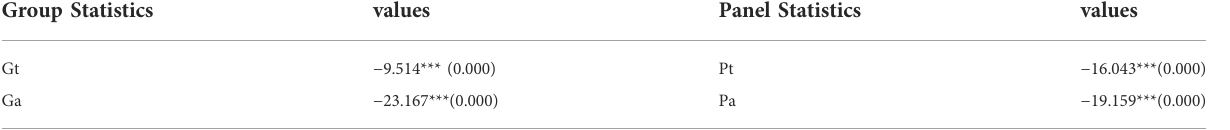
TABLE 5 The (Westerlund-2007) Cointegration results.